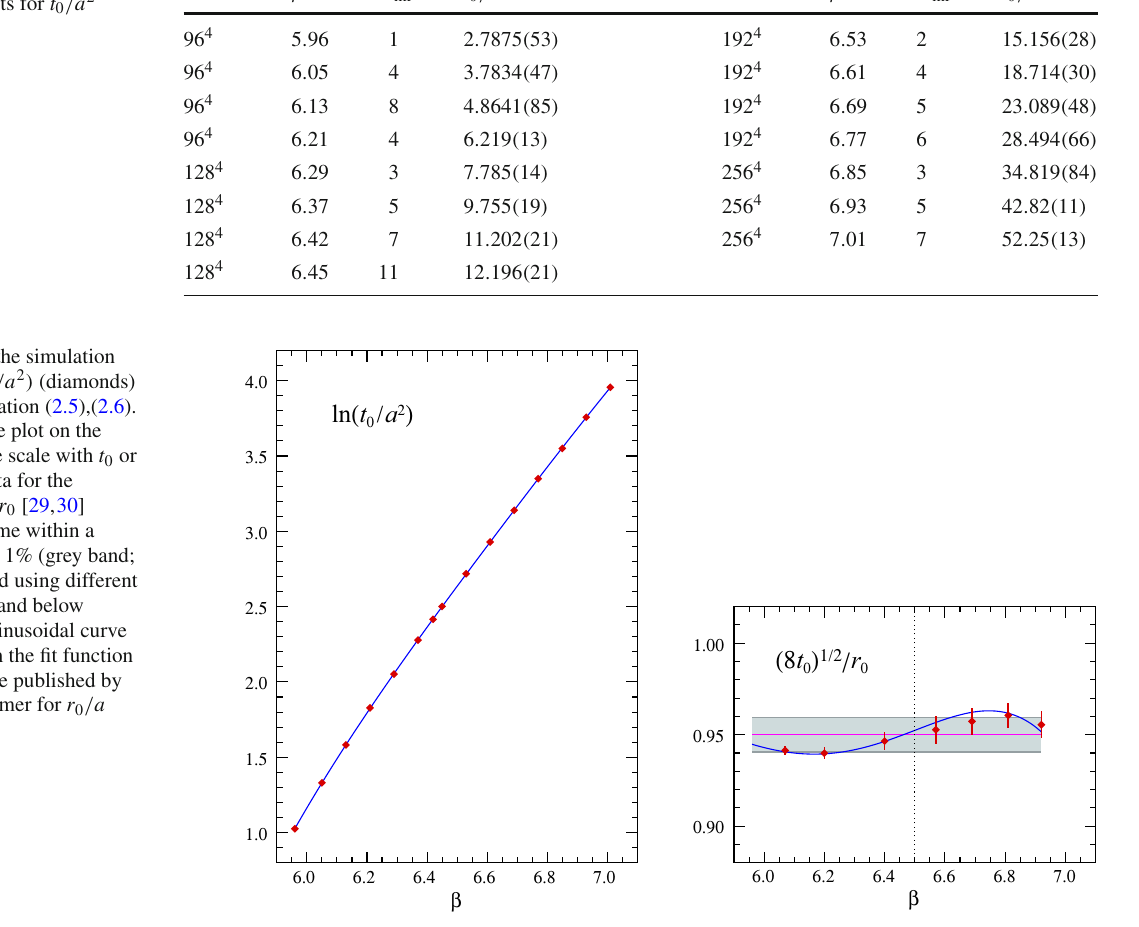
Table 1 Lattice parameters and simulation results for t 0 / a 2